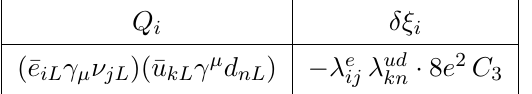
Table 9 . Operators Q i and coe(cid:14)cients (cid:14)(cid:24) i for the semileptonic part of the e(cid:11)ective Lagrangian (cid:14) L QED involving charged currents. For the down-type quarks generation indices run from 1 to 2, e(cid:11) while for up-type quarks we only keep the (cid:12)rst generation. The (cid:14)(cid:24) i coe(cid:14)cient for the Hermitian conjugate operator can be easily